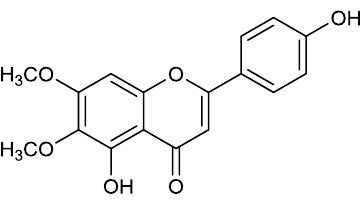
Figure 7. Chemical structure of